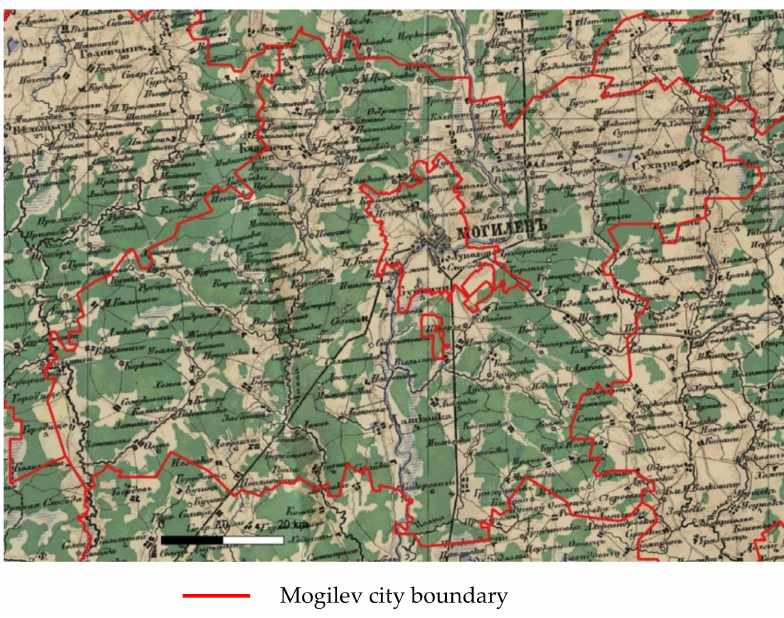
Figure A2. The Mogilev Governorate map tile (1871).